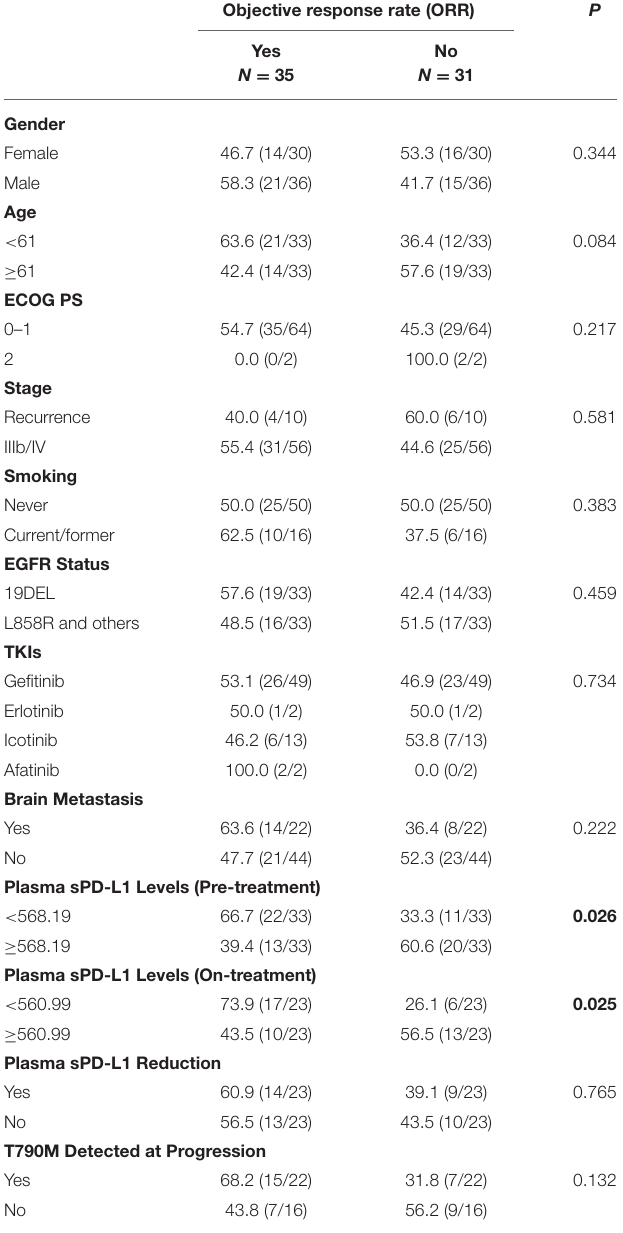
TABLE 3 | Clinical characteristics of patients and distributions of sPD-L1 concentrations according to the therapeutic response to EGFR-TKIs. Objective response rate